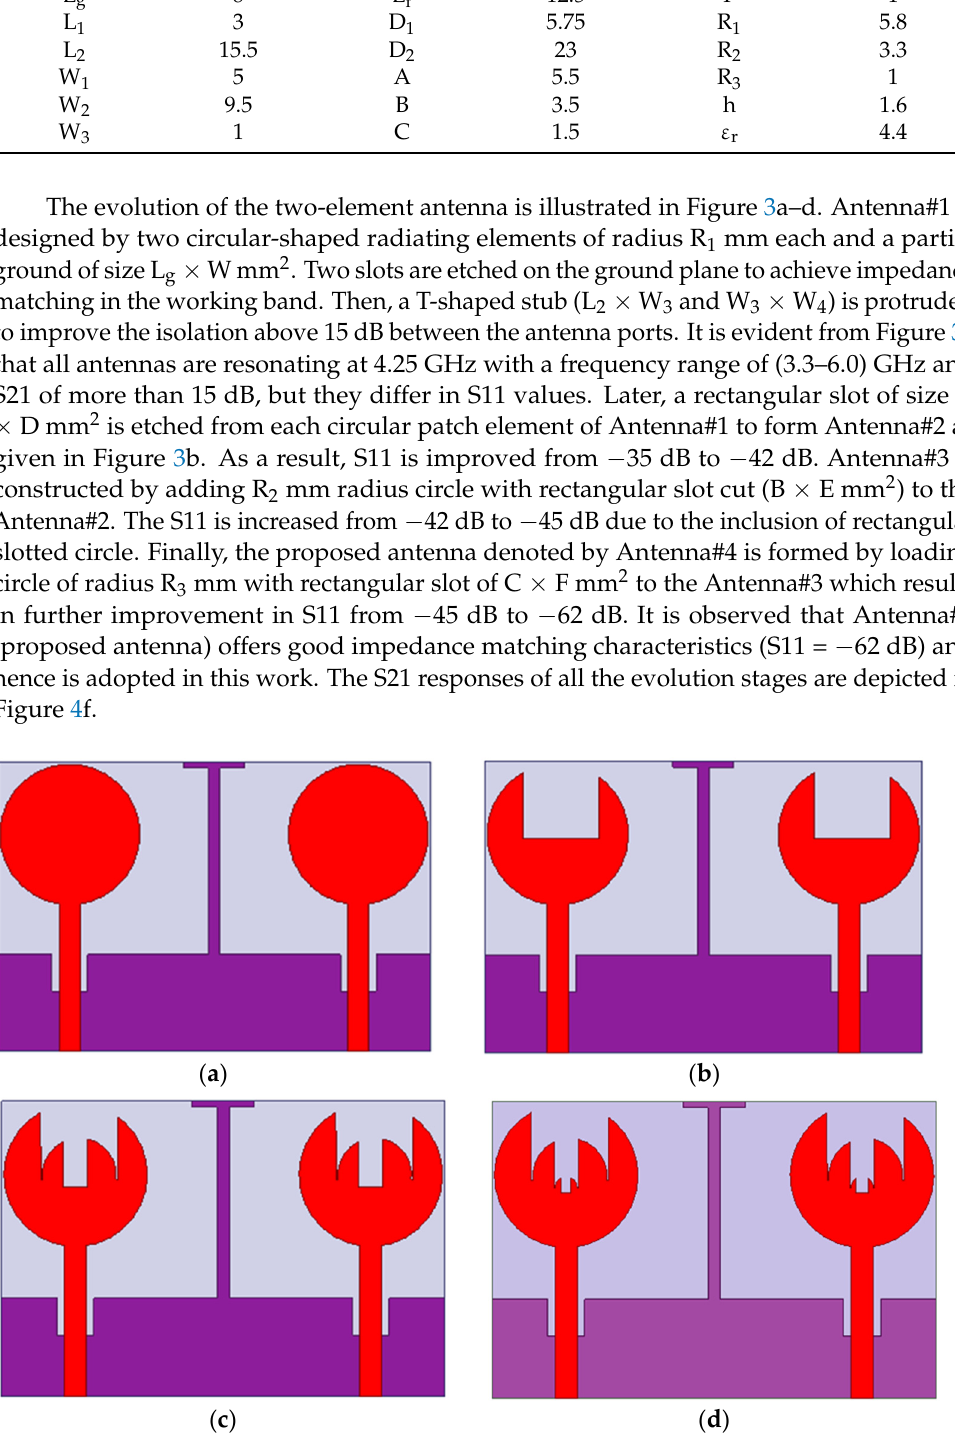
Table 1. Design parameters of the two-element MIMO antenna.